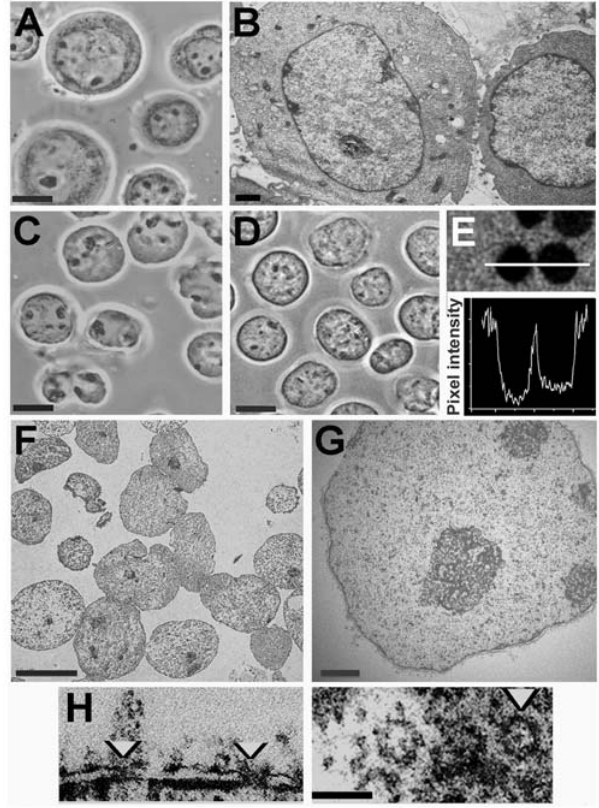
Figure 1. Nuclei of K562 cells released in polymer solution containing 100 m M K-Hepes. Cells suspended in 70 kDa Ficoll (50% w/ v) or 70 kDa dextran (35% w/v) containing digitonin were vortexed to disperse cytoplasmic material, and nuclei were centrifuged and fixed in the same polymer solution. (A) intact cells in growth medium, phase contrast. (B) intact cells, electron microscope section. (C, D) nuclei isolated in Ficoll or dextran respectively, phase contrast. (E) nuclei incubated as in D indextranwith additionof fluorescein-labelled dextran ofthe same size, fluorescence image of an approximately midplane 0.5 m m confocal section after 1 h; lower panel shows a scan of fluorescence intensity along the white line. (F, G)nuclei isolated inFicoll and processed as inB, electron microscope images of sections. (H) nuclear pores (arrowheads) in nuclei isolated in Ficoll seen in transverse (left) and tangential (right) electron microscope sections. Bars 10 m m (A, C, D, F); 1 m m (B, G); 0.2 m m